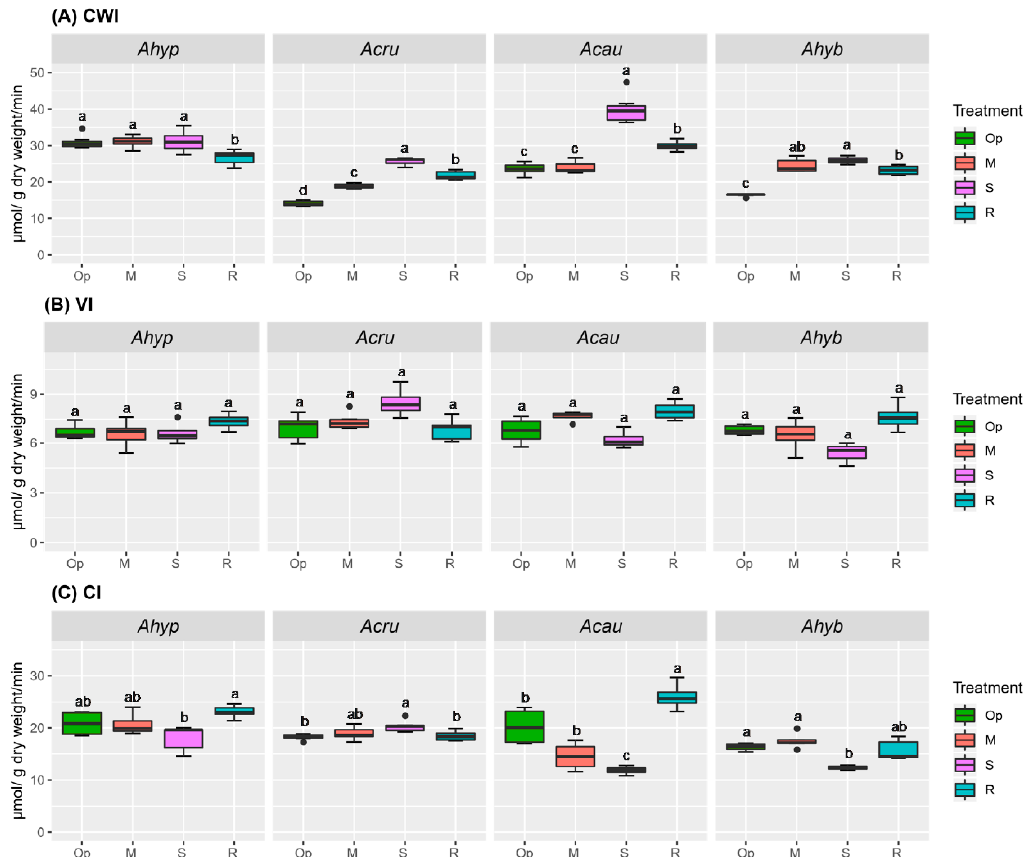
Figure 3. Invertase activity in leaves of amaranth plants subjected to water-deficit stress. ( A ) Cell wall invertase [CWI], ( B ) vacuolar invertase [VI], and ( C ) alkaline / neutral cytoplasmic invertase [CI] activities in leaves of Amaranthus hypochondriacus (Ahypo), A. cruentus (Acru), A. caudatus (Acau), and A. hybridus (Ahyb) plants growing in optimal conditions (Op), subjected to moderate (M) or severe (S) water-deficit stress, or allowed to recover from S, 1 day after normal watering was restored (R). Different letters over the box-and-whisker plots represent statistically significant differences at p ≤ 0.05 (Tukey Kramer test; n = 9). Box-and-whisker plots show high, low, and median values. The results shown are those obtained from a representative experiment that was repeated in the spring-summer and summer-autumn seasons of 2015, respectively, with similar results.